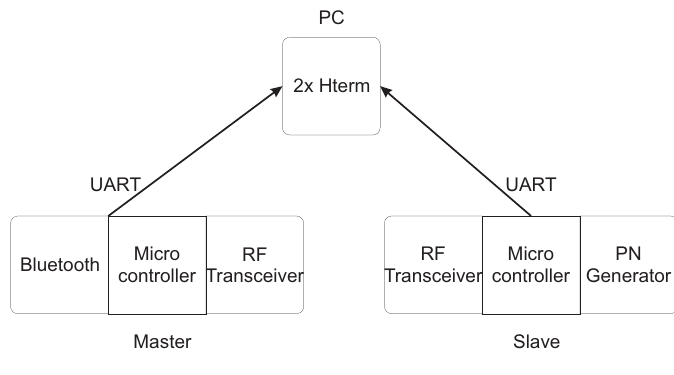
Figure 5. Diagram of the data interception setup of the master and slave node. A terminal program called Hterm is used to record the serial data